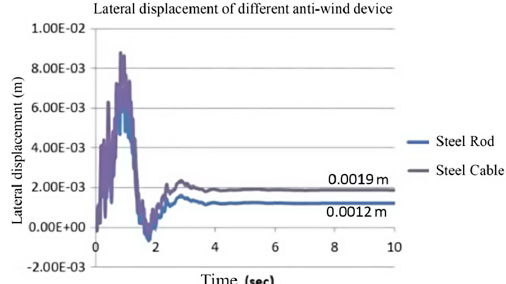
Figure 18. Lateral force P acting on central node of bridge deck